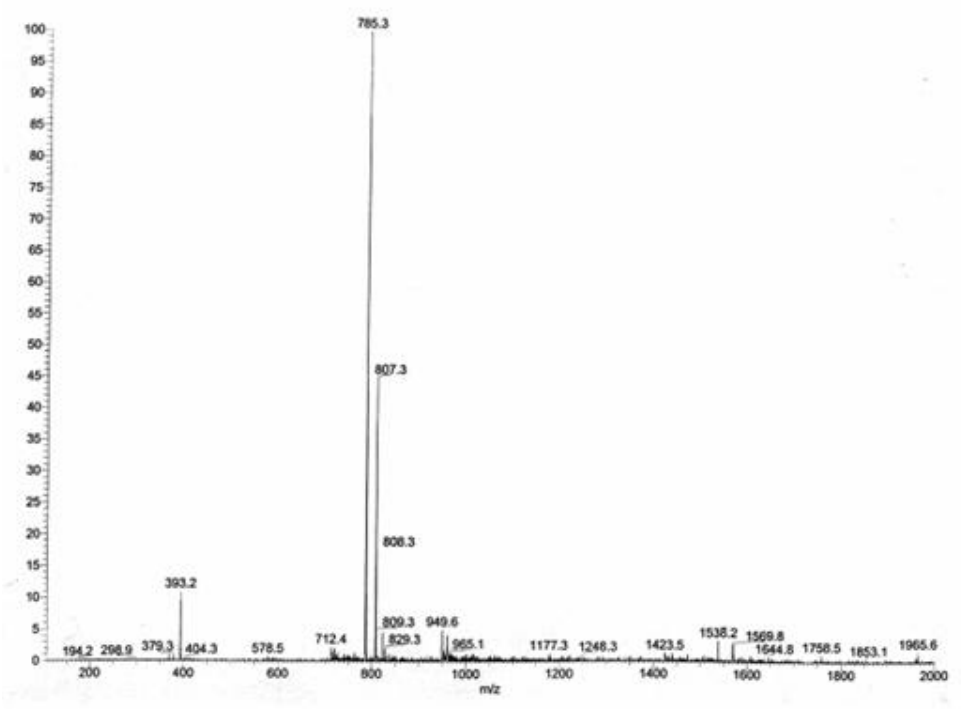
Figure 1. ESI mass spectrum of 3